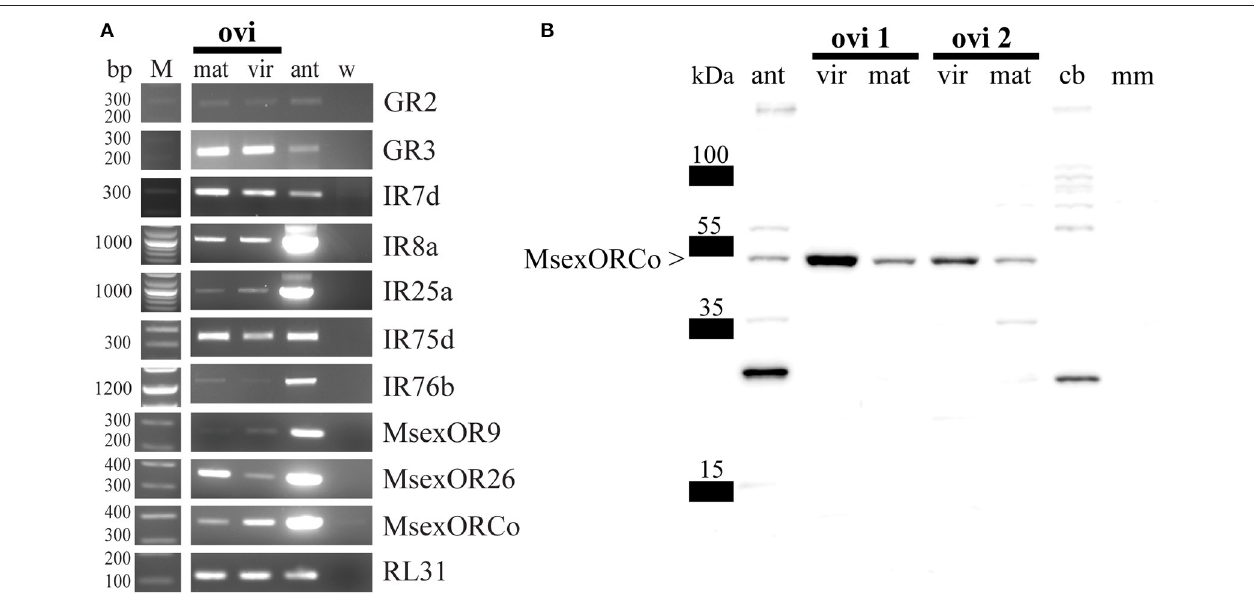
FIGURE 1 | (A) Representative RT-PCR amplifications of RL31 (house keeping gene, encoding a ubiquitous ribosomal protein) and several chemosensory receptor transcripts using female cDNA of virgin and mated M. sexta ovipositor tissue. Bands of the predicted size revealed expression of MsexGR2, MsexGR3, MsexIR7d, MsexIR8a, MsexIR25a, MsexIR75d, MsexIR76b, MsexOR9, MsexOR26, and MsexORCo in both virgin and mated M. sexta ovipositors. M, marker; ant, female antenna; mat, mated; ovi, ovipositor; vir, virgin; w, water; RL31, ribosomal protein L31. (B) Western blot of different M. sexta tissues including ovipositor tissue. A signal near the predicted molecular weight of MsexORCo (53.7 kDa) indicates that the antibody recognizes MsexORCo in mated female antennae (ant) and ovipositor tissues of virgin and mated animals (ovi 1 and ovi 2 represent two independent samples). Central brain (cb) and male muscle (mm) tissues lack a signal at